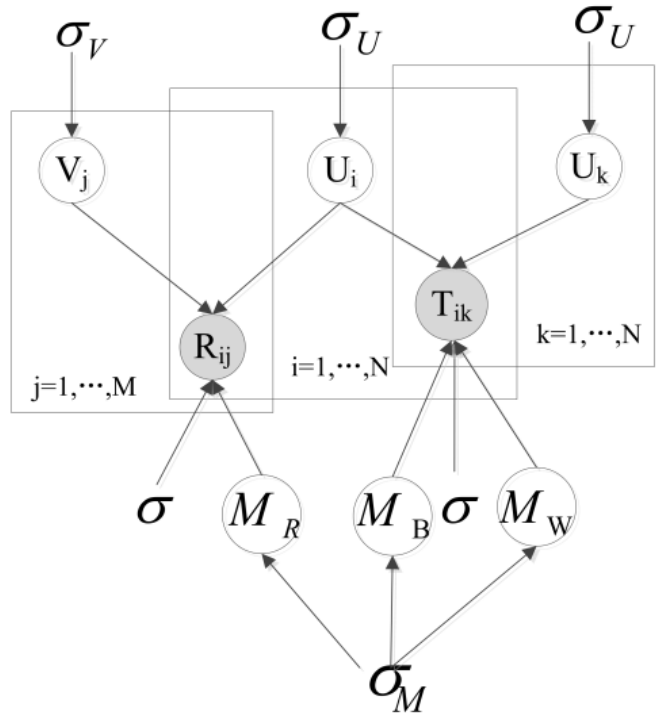
Figure 7. Probabilistic graphical model of UPPS.